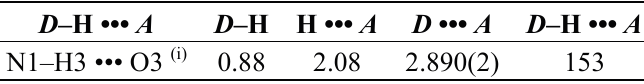
Table 4. Hydrogen-bond geometry (Å,